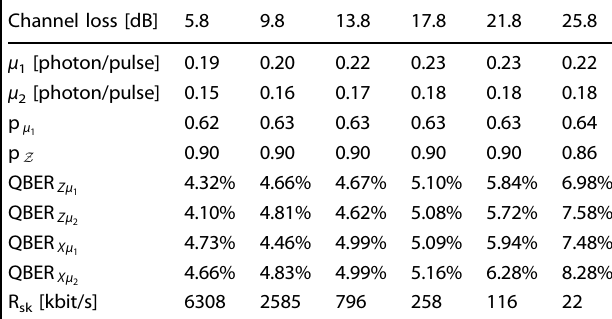
Table 1. Parameters experimentally used, measured QBER in all four possible con fi gurations of basis and intensity choice, and obtained secret key rate